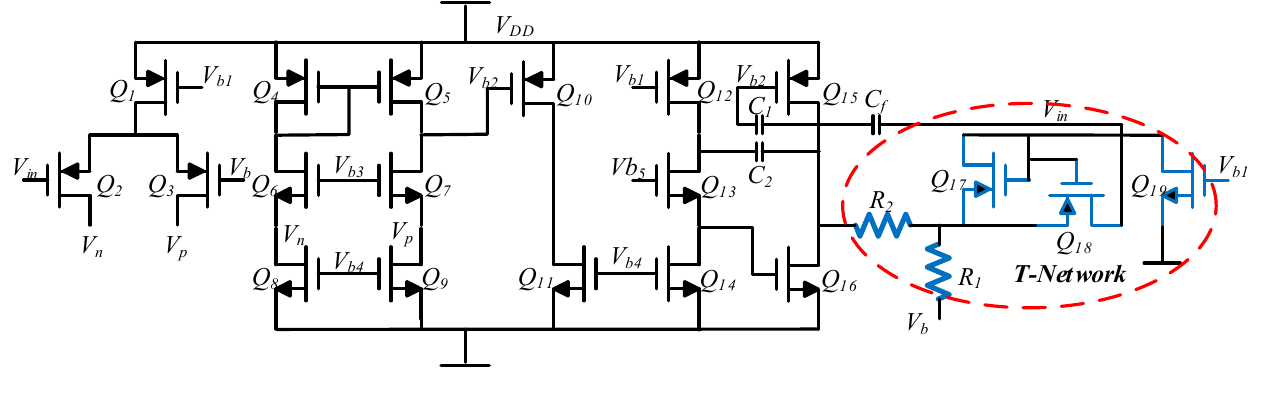
Figure 7. Charge amplifier circuit.